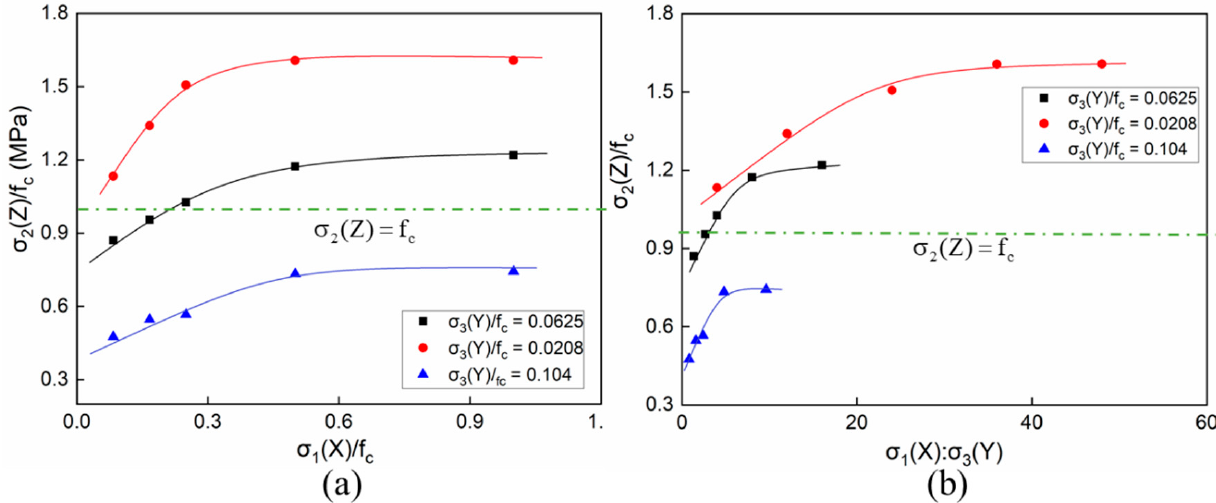
Figure 19. The compressive strength of concrete under compressive–compressive–tensile conditions: ( a ) σ 1 /f c along the horizontal axis and ( b ) σ 1 / σ 3 along the horizontal axis.